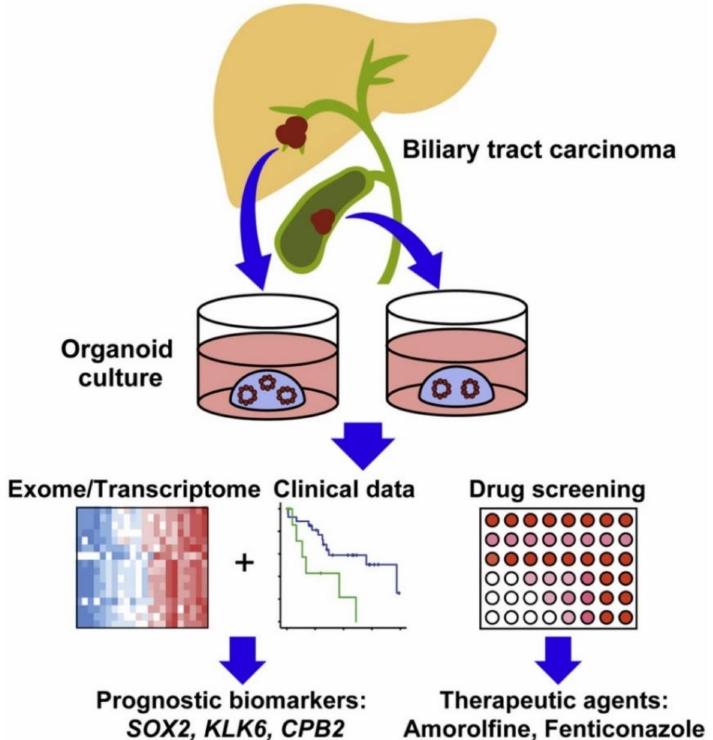
Figure 8. In vitro human cancer models for discovery of key prognostic cancer biomarkers. Adapted with permission from [136] © Elsevier